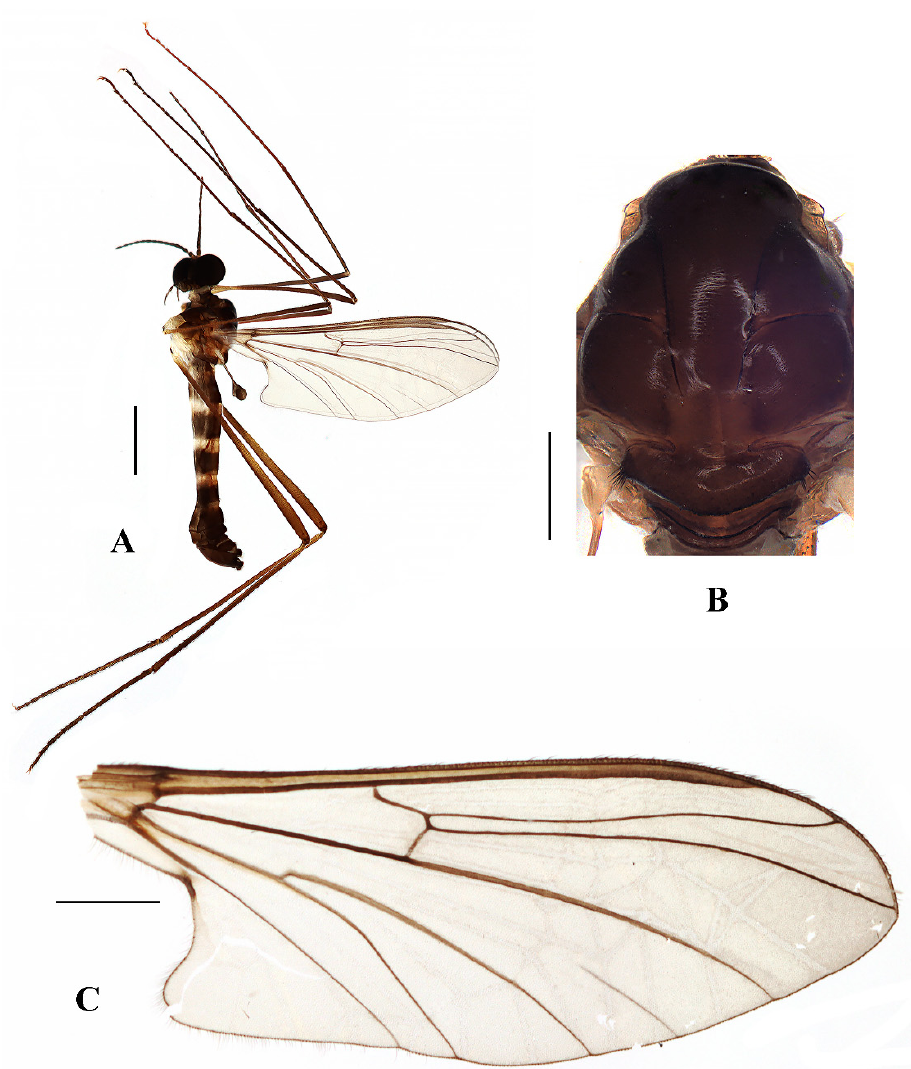
and mid tibiae dark brown with brownish black hairs; hind tibia brown with brownish cylindrical, brownish black with brownish black hairs; ultimate flagellomere 1.5 times black hairs; tarsomeres dark brown with brownish black hairs, hind tarsomere with a black length of penultimate flagellomere. Clypeus nearly rectangular, brownish black, twice as long hair basally; claw brown. Tibial spurs 0–0–0. Wing (Figure 8C) slightly brown apically, long as wide; labrum brownish yellow; labellum brownish yellow with brownish black sc brown; veins brown. Sc rudimentary, not ending at the base of Rs; Rs slightly curved hairs; proboscis about 0.52 times the length of head width. Palpus with five segments, 1st basally, 1.2 times as long as r-m; R 4 wavy, the length from the end of R 1 to end of R 4 shorter segment almost invisible; 2nd and 3rd segments cylindrical, brownish black with black than the length from the end of R 4 to end of R 5 ; r-m straight, included angle between r-m hairs; 4th segment cylindrical, slightly swollen apically, brownish black with black hairs; and Rs less than 90 degrees; the length from the end of M 1 to end of M 2 as long as the 5th segment slender, brownish yellow with brownish black hairs; relative length of distal length from the end of M 2 to end of CuA 1 . The base of halter is pale, the apex of halter four segments as 1.0: 0.8: 1.0: 2.3. brownish black, with brownish-black hairs.